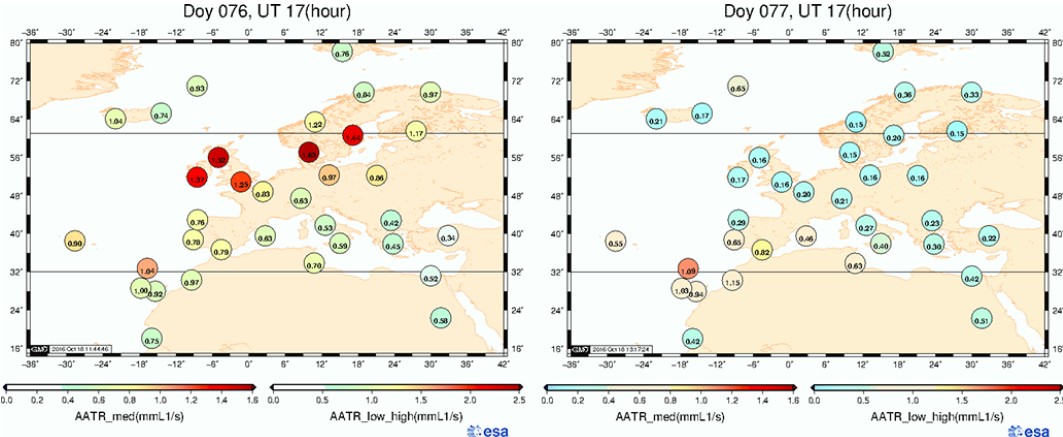
Figure 21. EGNOS RIMS AATR for 17 (left) and 18 (right) March 2015 at 17:00 extracted from MONITOR products (http://monitor.estec.